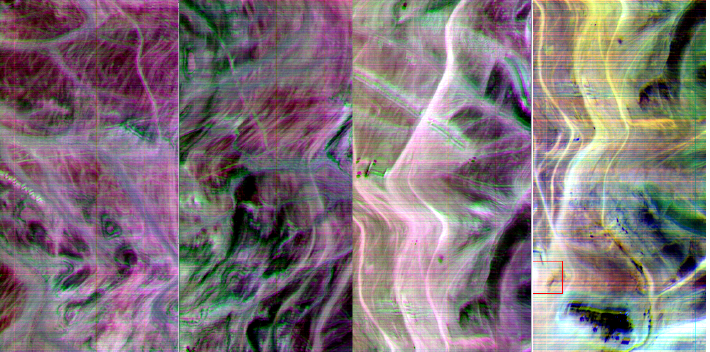
Figure 4. The dataset “desert” is an hyperspectral image of a desert place taken by an airplane flying 10,000 feet above sea level. The resolution is 1.3 m/pixel, 286 × 2,640 pixels per waveband with 168